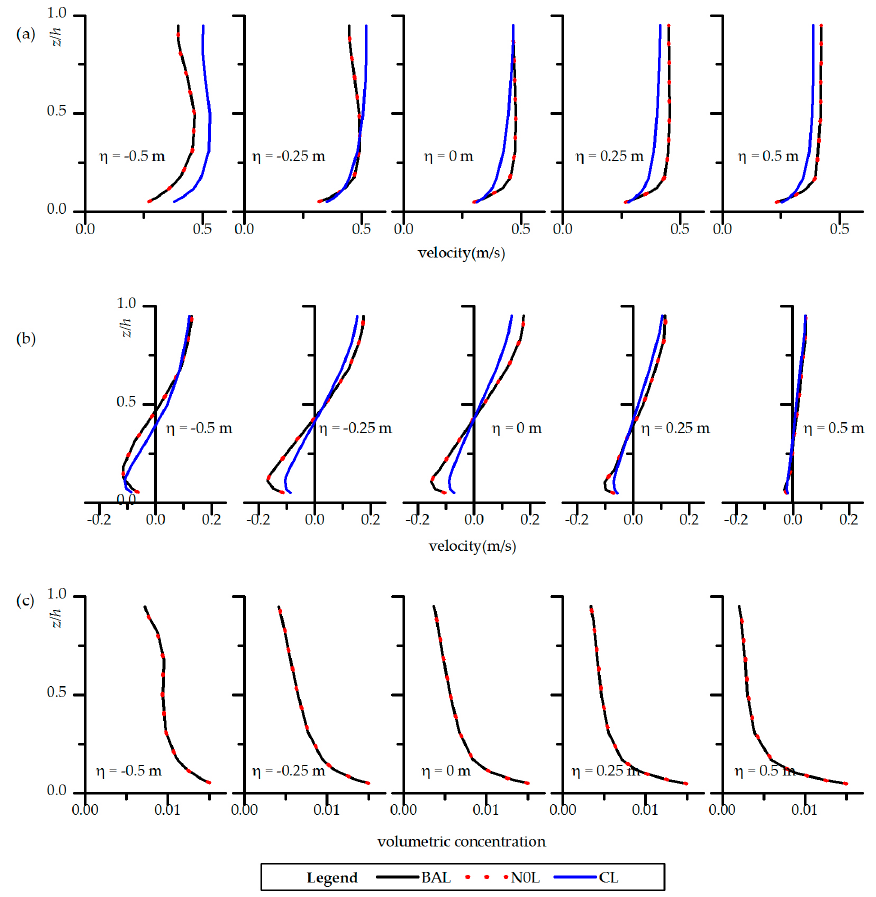
Figure 7. Velocity and sediment concentration profiles at the cross-section 90° for lower concentration case: ( a ) Streamwise velocity; ( b ) transversal velocity; ( c ) sediment volumetric concentration. (velocity unit: m/s).